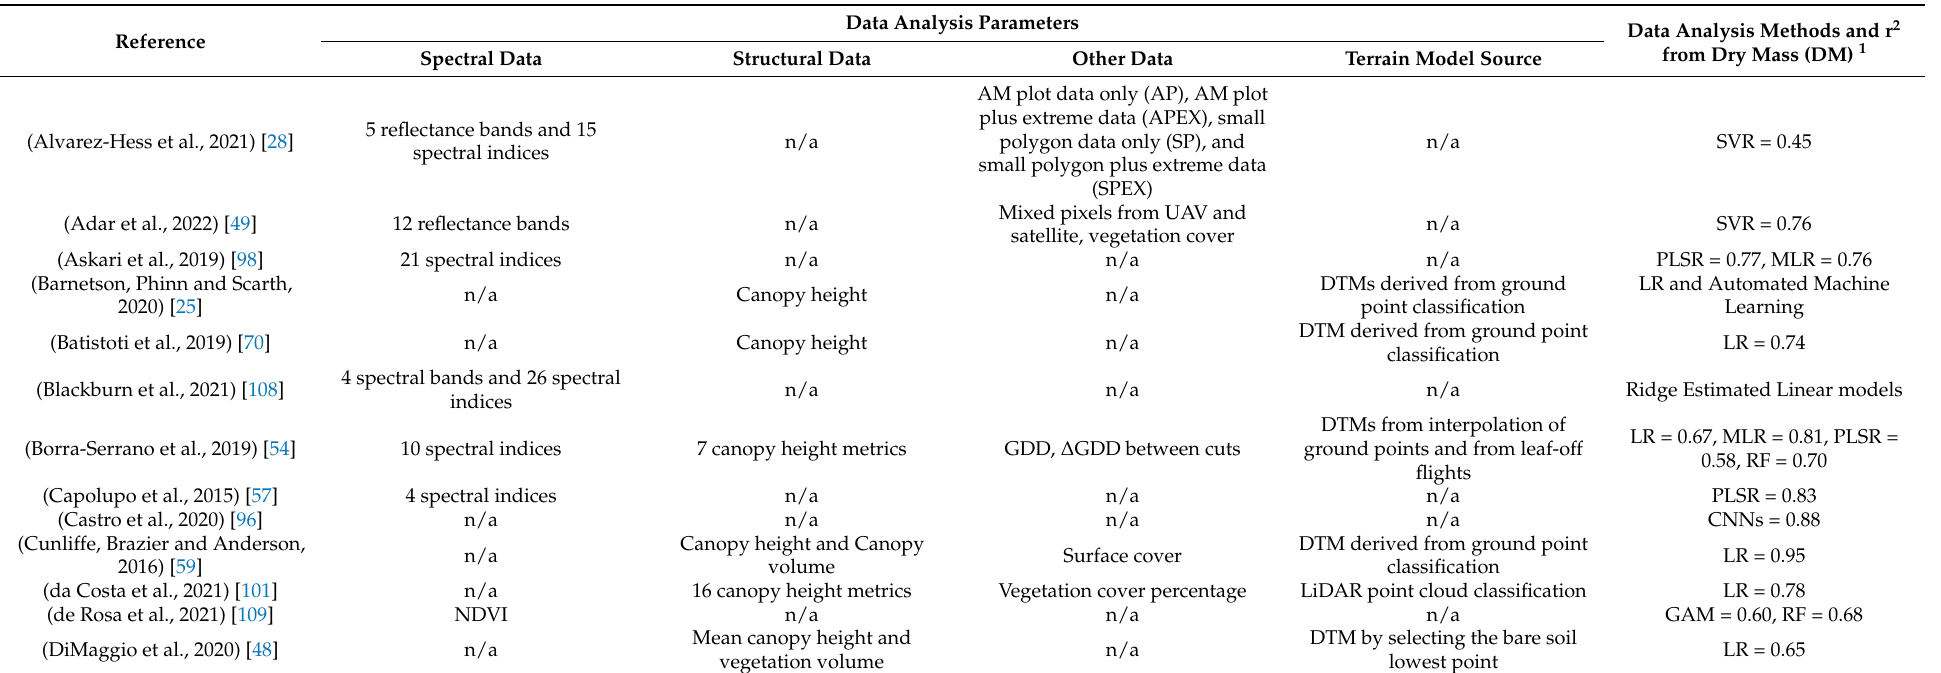
Table A3. Data analysis methods and essential results of the papers considered in this